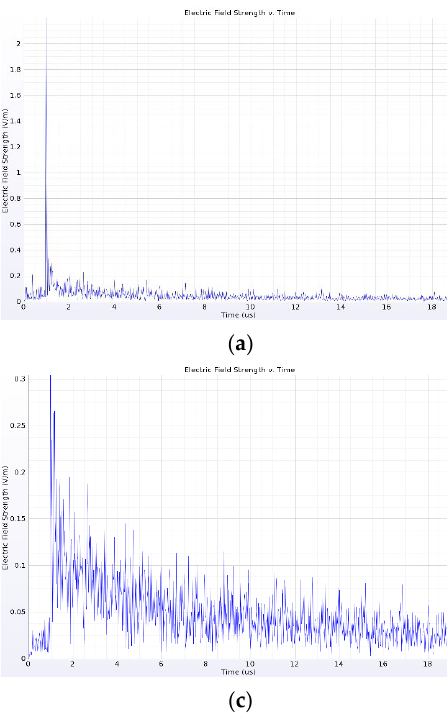
Figure 8. Location distribution of source and point sensors around insulator .